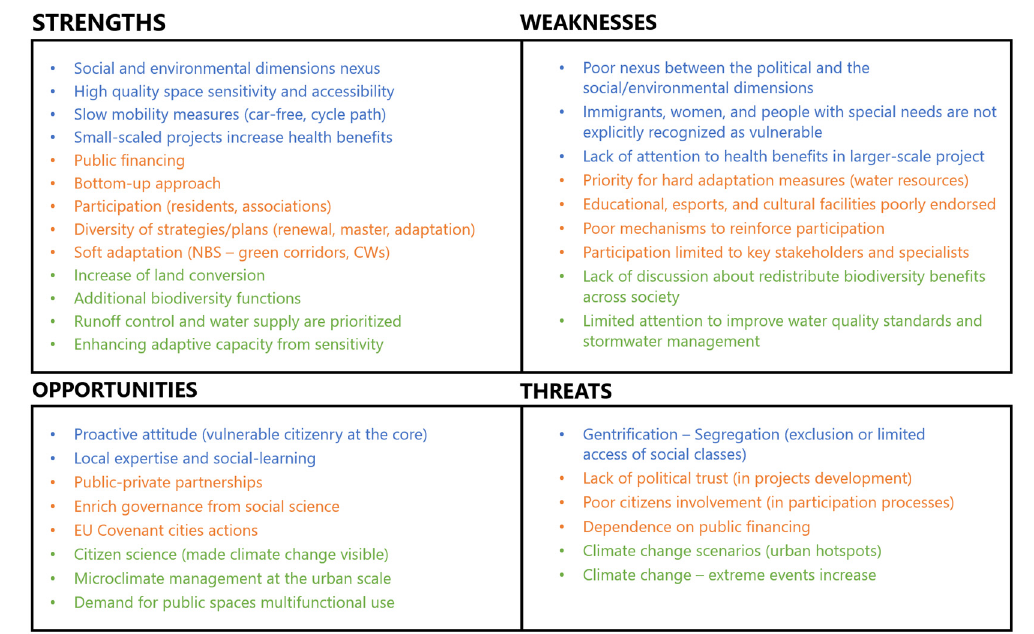
Figure 4. SWOT analysis on social, political, and environmental dimensions. Note: Blue colour recaps social dimension attributes, orange colour those that form the political dimension, and learnings from the environmental dimension are highlighted in green. A hierarchy is used to put on top of each dimension list (colour) those issues shared the most by the experiences.